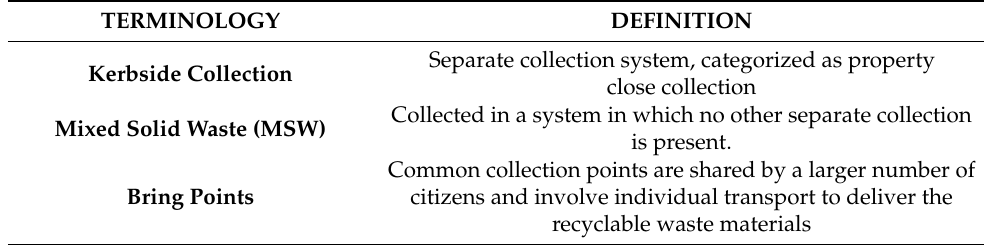
Table 1. List of definitions of different collection systems